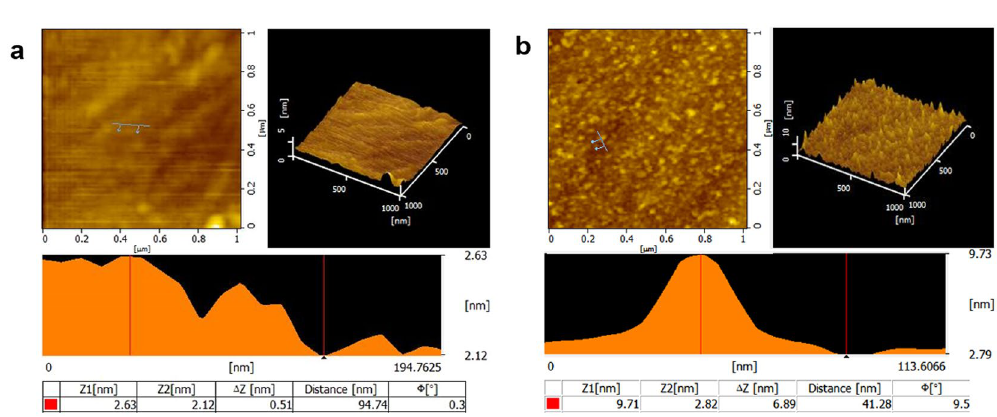
Figure 5. AFM topography images of ( a ) bare and ( b ) BSA-MC-LR conjugate modified waveguide chip, including a 1 µ m × 1 µ m plane AFM image (Higher left), a 3-D AFM topography image (Higher right), and cross-section height variations taken at a rough area (Lower: position indicated by blue line in the topographic